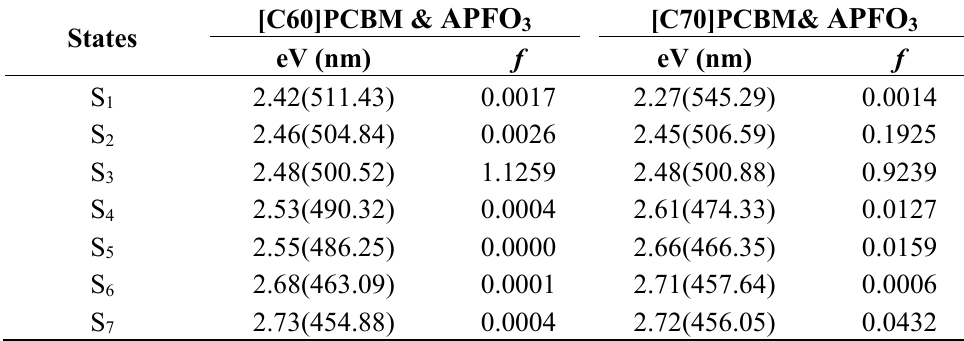
Table 2. Calculated transition energies (eV, nm) and oscillator strengths ( f )